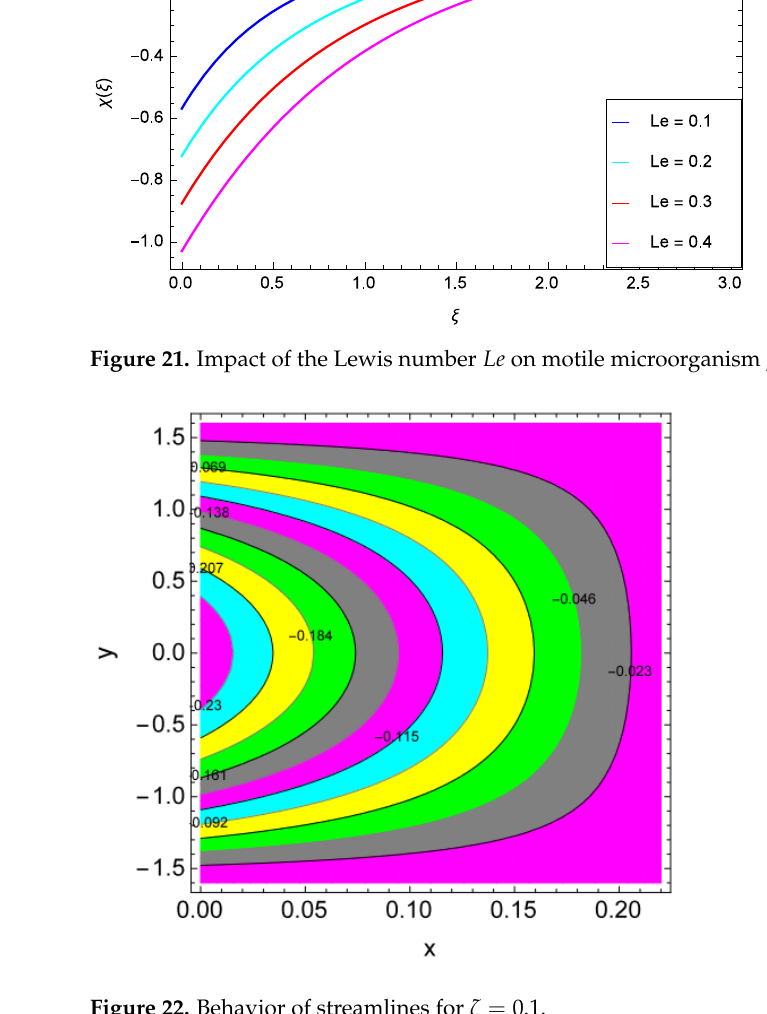
Figure 22. Behavior of streamlines for ζ = 0.1.